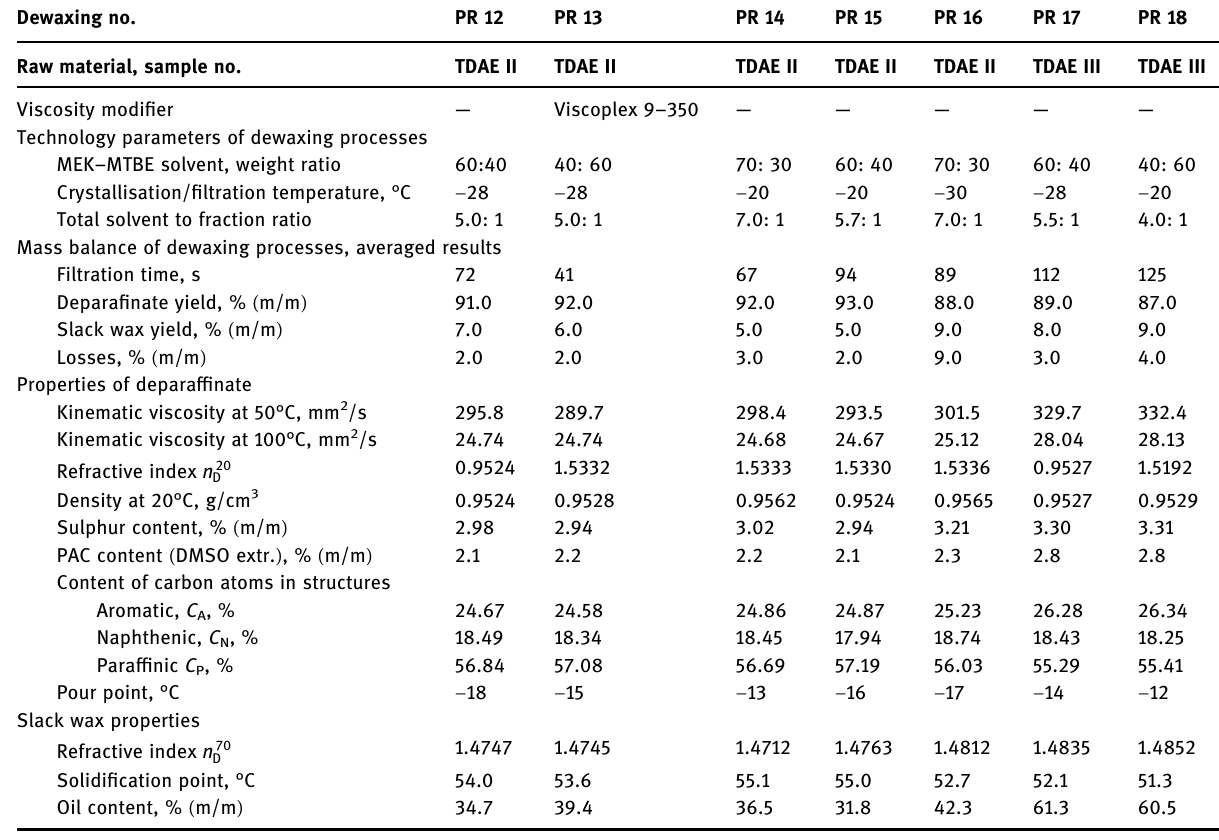
Table 6: Technology parameters, mass balance and properties of the obtained depara ffi nates and slack waxes, in MEK – MTBE dewaxing processes of a TDAE II and TDAE III raw material samples Dewaxing